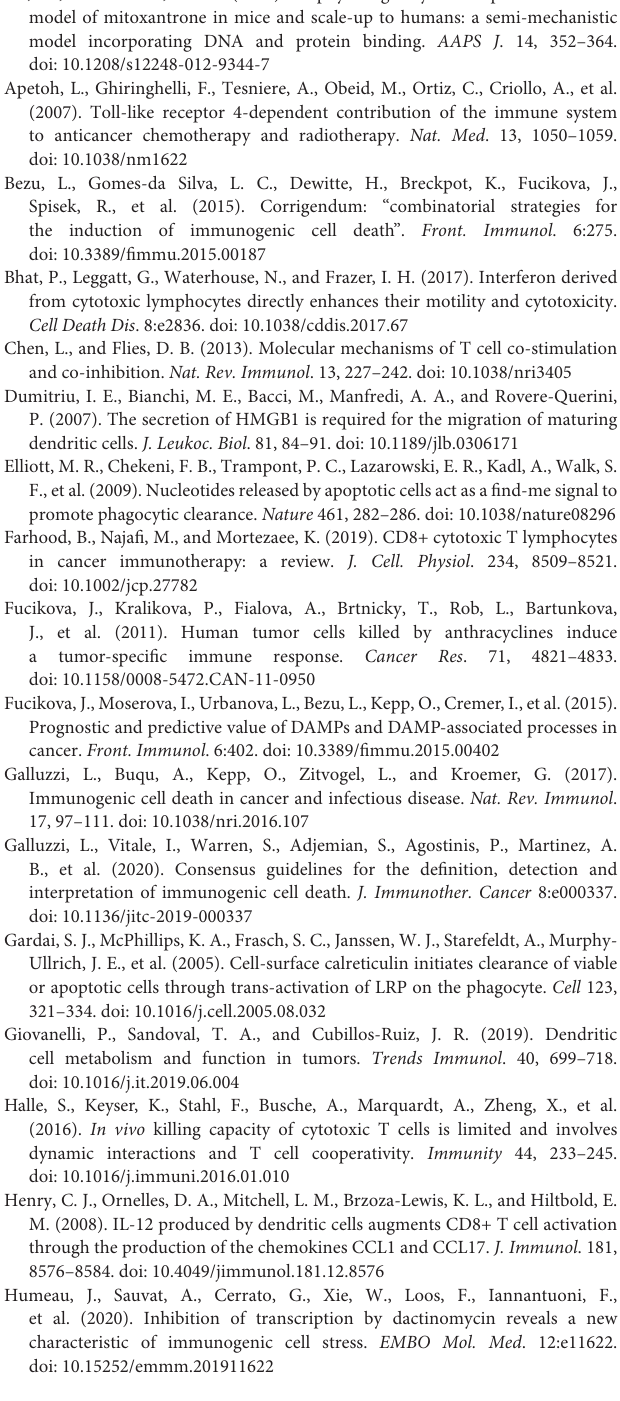
Supplementary Figure 2 | CD4 + cell dynamics with description of cell differentiated lineages and the role of the cytokines in the activation of the CD4 + T cell dynamics. Black arcs represent activating influences and red arcs inhibiting